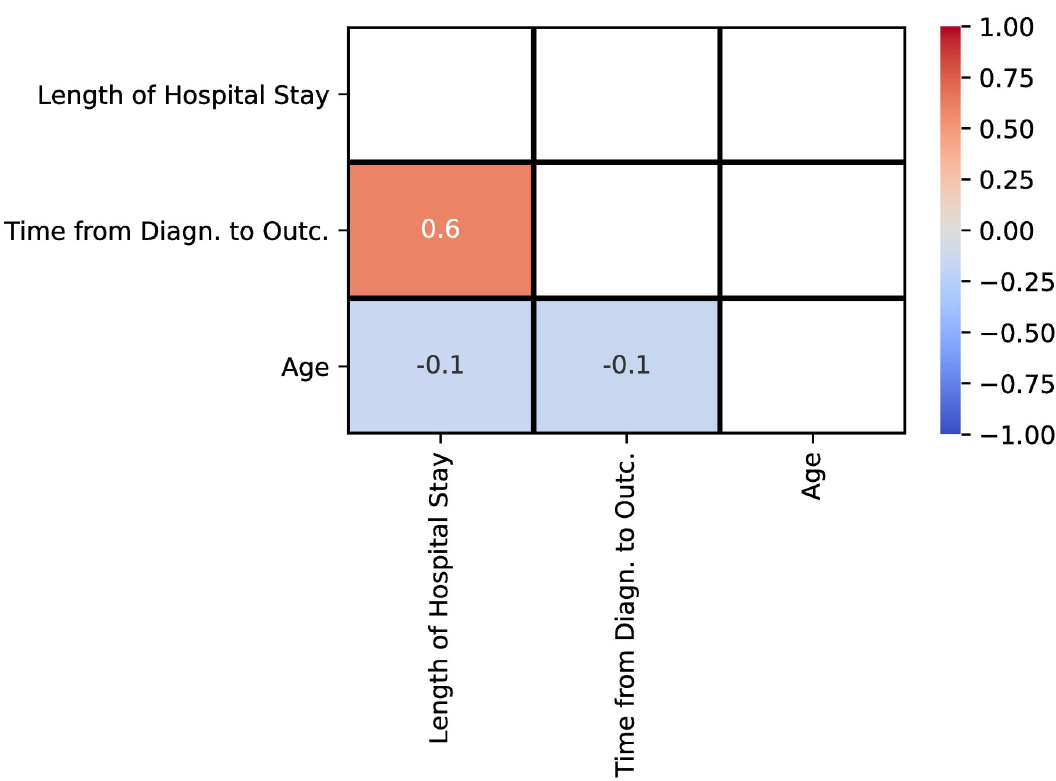
Fig 2. Pearson correlation matrix for age, length of hospital stay and time from diagnosis to definitive outcome variables. “Time from diagn. to outc.” is an abbreviation for “Time from diagnosis to definitive outcome”.